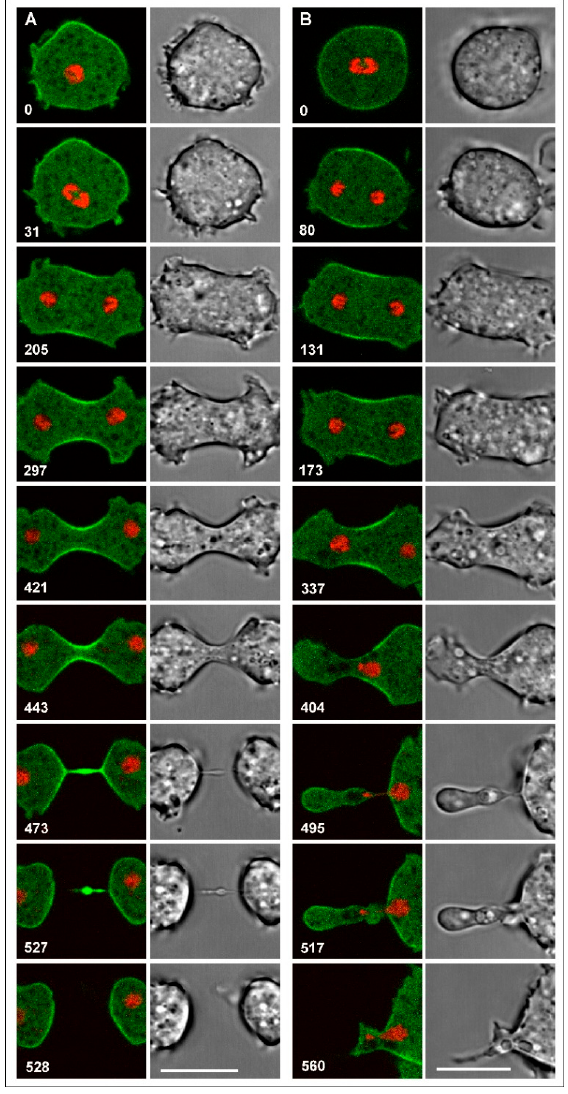
Figure 2. Successful and failing cytokinesis in mononucleate myosin-II-null cells. Cells attached to a glass surface are shown in confocal fluorescence (left panels) and bright field images (right panels). The cells expressed GFP-cortexillin I (green), together with mRFP-histone 2B as a label of the chromosomes. Time is indicated in seconds after the first frame. Scale bars, 10 µm. The entire sequences of ( A ) and ( B ) are shown in supplementary Video S3. ( A ) Successful cell division showing